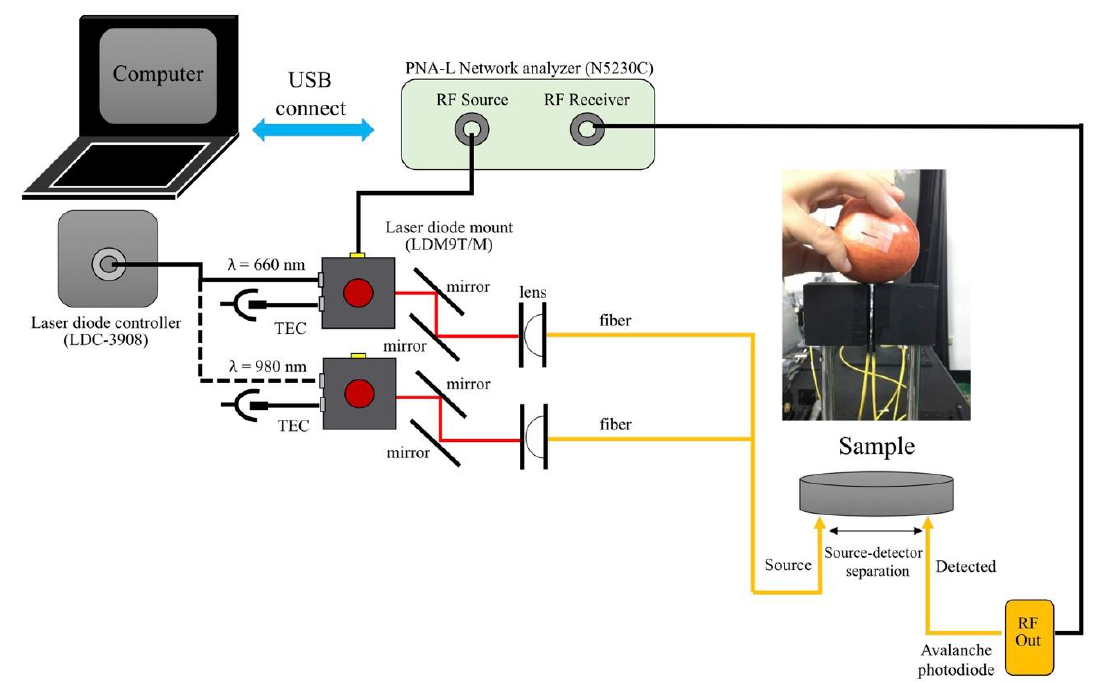
Figure 1. Schematic of the frequency-domain diffuse reflectance spectroscopy (DRS) system configuration.